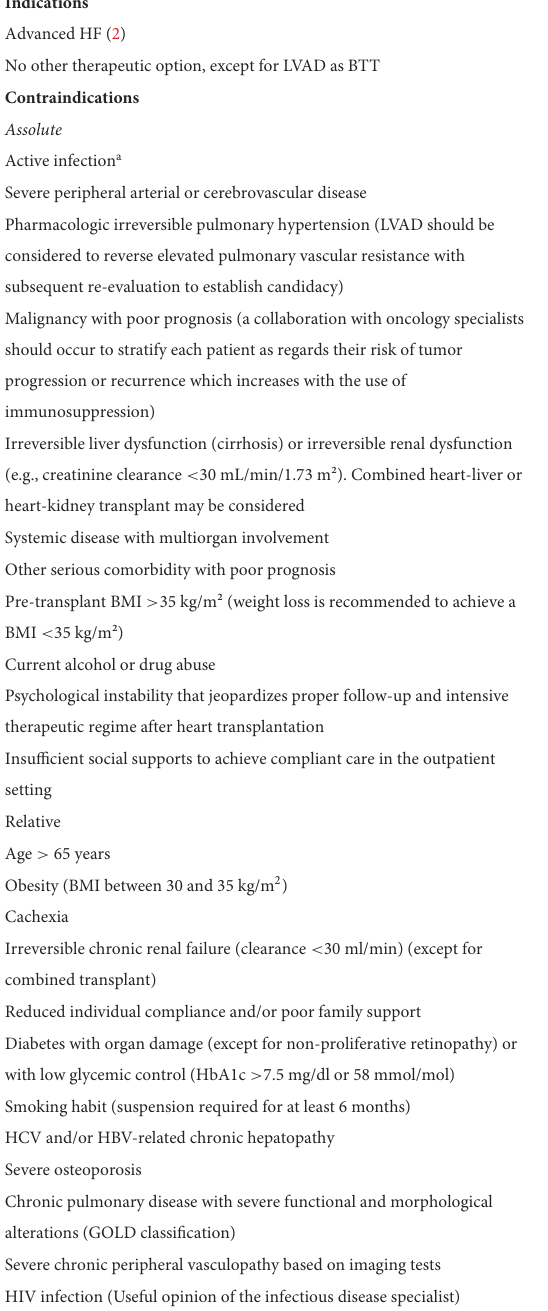
TABLE 1 Heart transplantation: Indications and contraindications. TABLE 2 Traditional cardiac donor selection